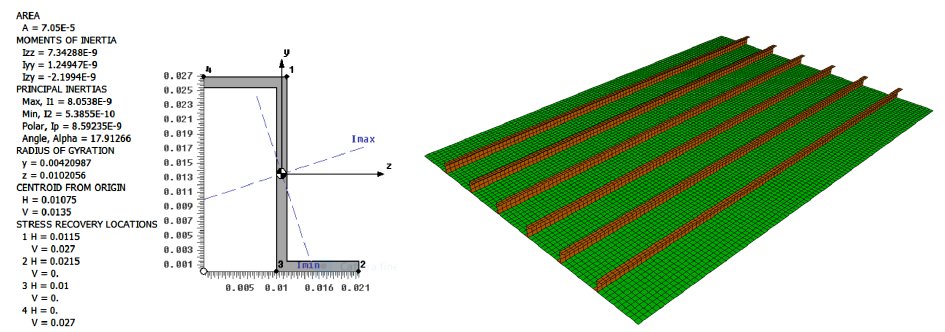
Figure 13. Conventional flat panel with stiffeners